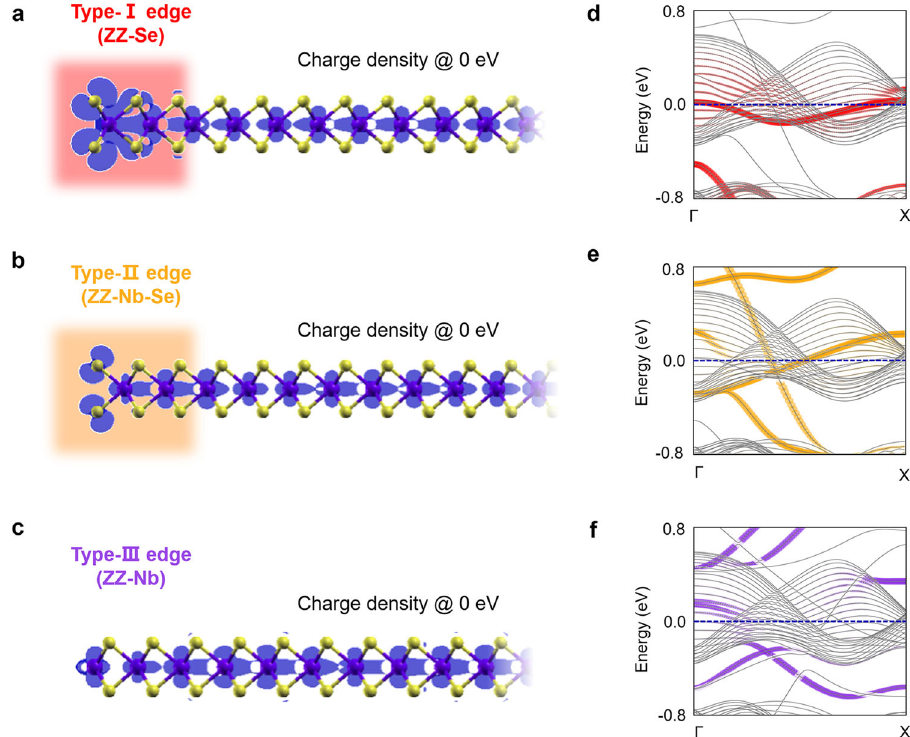
Fig. 3 Density functional theory (DFT) calculations of both the charge densities and the electronic band structures at the zigzag (ZZ) edges in monolayer NbSe 2 . a – c Atomic con fi gurations of the monolayer NbSe 2 ZZ nanoribbons with type-I (ZZ-Se), type-II (ZZ-Nb-Se), and type-III (ZZ-Nb) edges, respectively. The spatially resolved charge densities at Fermi energy ( E F ) are superposed on the con fi gurations. d – f Electronic band structures for the type-I, II, III edges in monolayer NbSe 2 . The edge states are highlighted by the colored dots, and the sizes of the dots represent the proportion of the edge Se/Nb orbitals to the energy bands. The Fermi energy E F is marked by the dashed